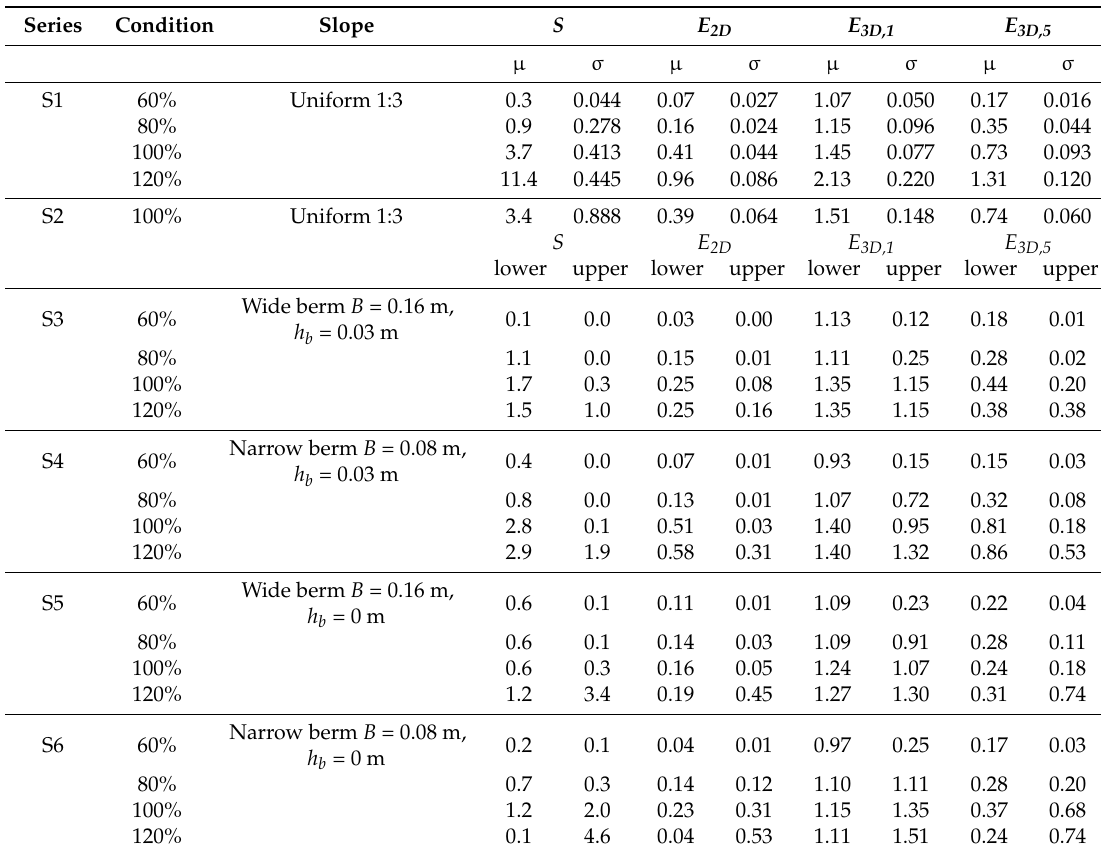
Table 2. Test results ( µ denotes the mean value of the five tests and σ denotes the corresponding standard deviation; ‘lower’ denotes the part of the slope below the berm plus the berm, and ‘upper’ denotes the slope above the